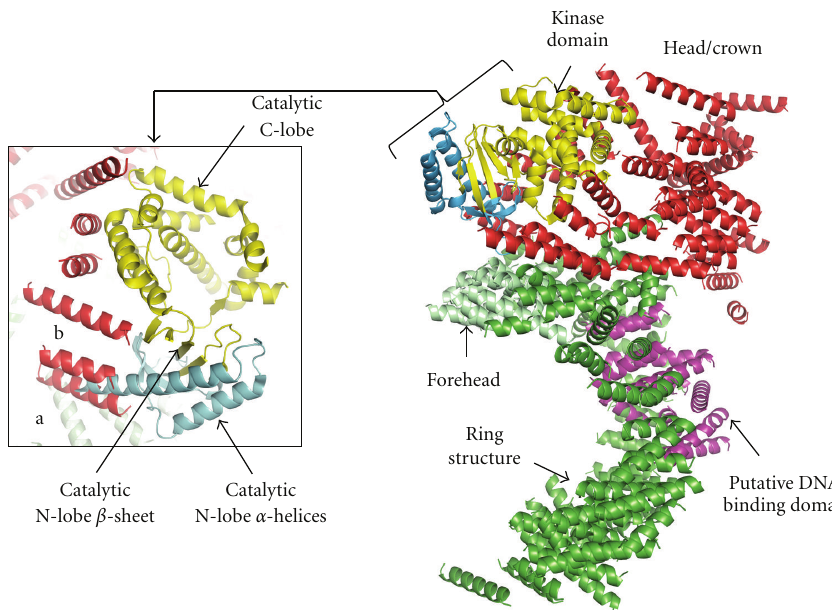
Figure 8: DNA-PKcs kinase domain. The figure shows a cartoon of the overall structure of DNA-PKcs depicting the position of the kinase domain. The colour coding is as shown in Figure 6. The modelling of DNA-PKcs catalytic domain was based on the crystal structure of one of its family members, the PI(3)K γ kinase (PDB code: 1E8X). Also shown is a closeup of DNA-PKcs catalytic domain. Helices of DNA-PKcs labelled (a) and (b) could be occupied by helices from the N-lobe of PI(3)K γ . The N-lobe helices displayed in light blue were omitted from the final structure of DNA-PKcs due to unclear electron density in this region.